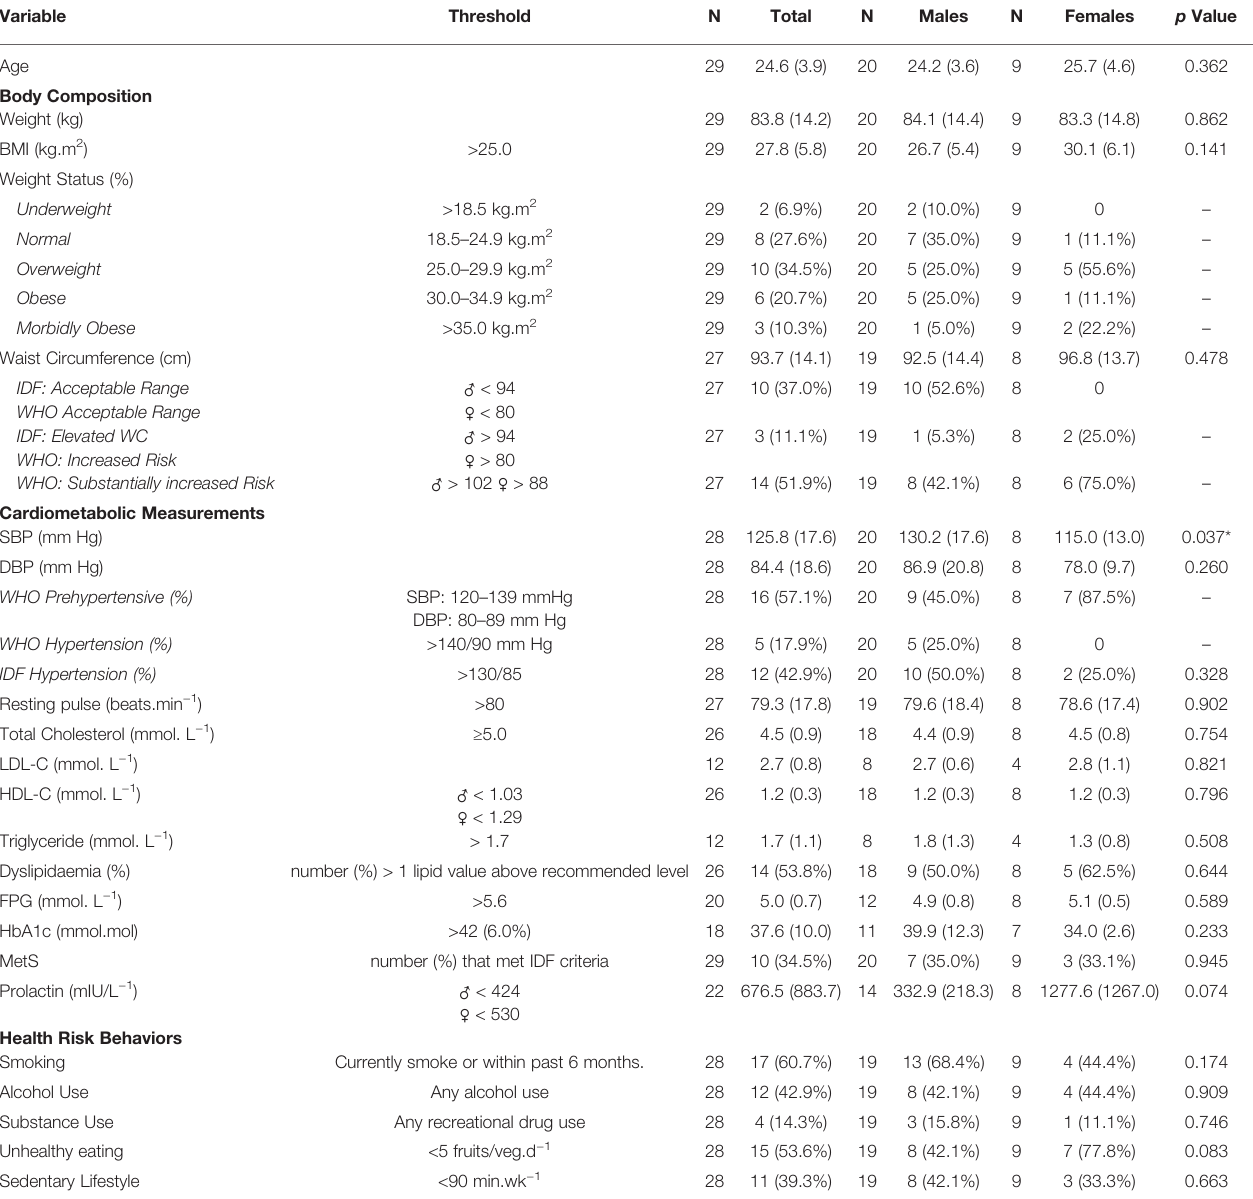
TABLE 3 | Cardiometabolic risk status for individuals with DUP < 1